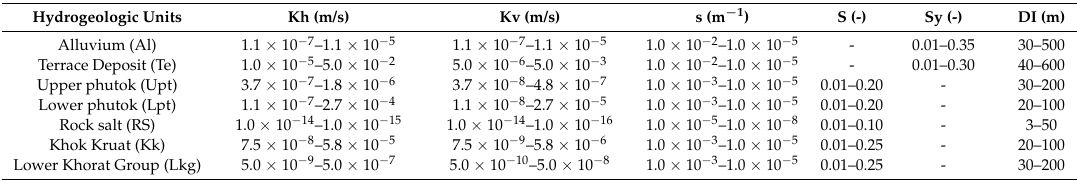
Note: Horizontal hydraulic conductivity = Kh, Vertical hydraulic conductivity = Kv, Storativity (for confined aquifer) = S, Specific yield (for unconfined aquifer) = Sy, Specific storage = Ss, Longitudinal dispersivity =